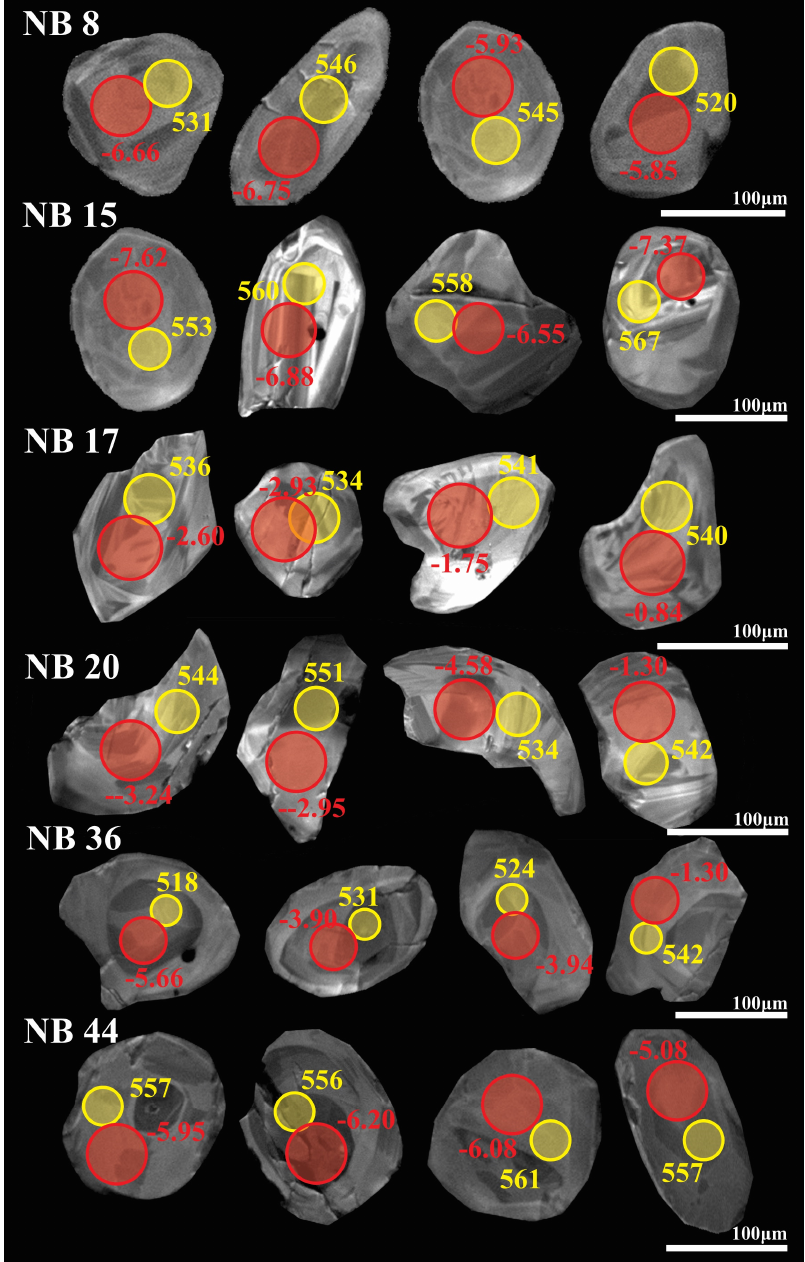
Figure 8. Cathodoluminescence images of selected zircon grains from gabbros. Yellow circles mark the position of the laser spot for U-Pb dating with 206 Pb/ 238 U ages (in Ma) and red circles mark the position of Hf isotope with ε Hf (t) analysis. Laser spot sizes are scaled to size. Sample NB8: Twenty-one spots were analysed from the sample, which shows a Th/U distribution between 0.26 and 0.38. 206 Pb/ 238 U ages of the sample range between 520 and 554 Ma with nineteen grains defining a weighted mean 206 Pb/ 238 U age of 529 ± 4 Ma (MSWD = 3.3). Additionally, thirteen grains represent a coherent concordia population at